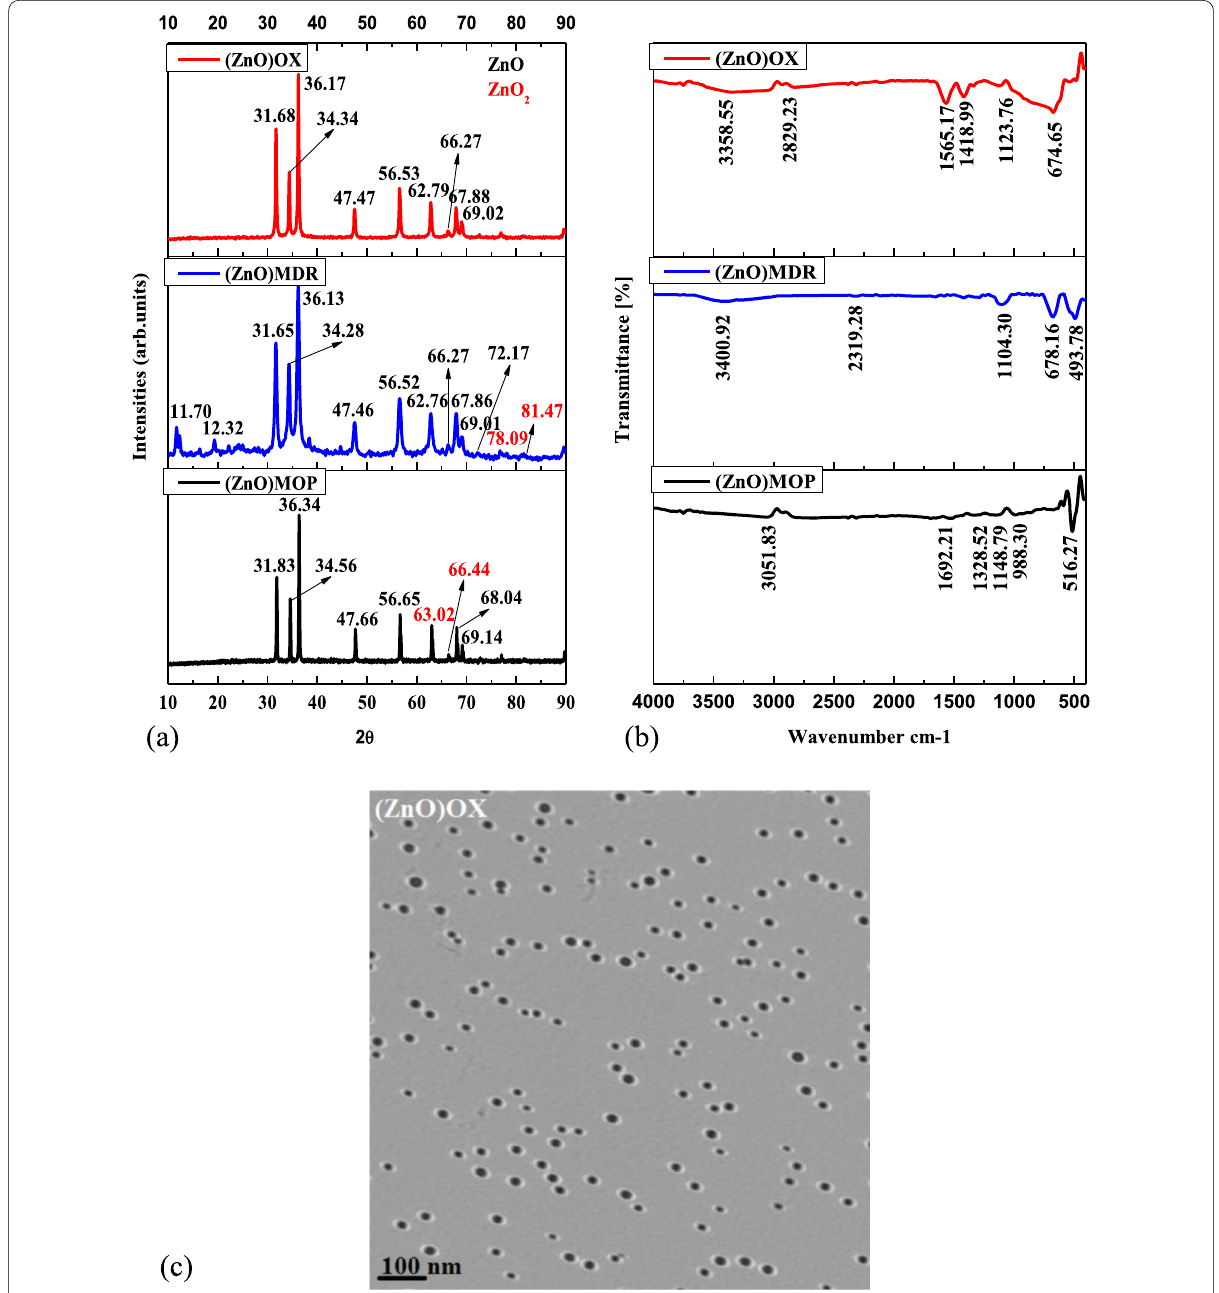
Fig. 1 a X‑ray diffraction spectra and b Fourier transform infrared spectroscopy spectra were obtained using the three preparation methods. c Transmission electron microscopy images of zinc oxide (ZnO) nanoparticles obtained using the oxalic acid ((ZnO)OX))